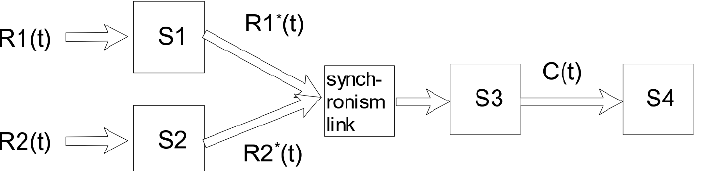
Figure 1. Synchronous calculation and transmission service model for the monitoring system.